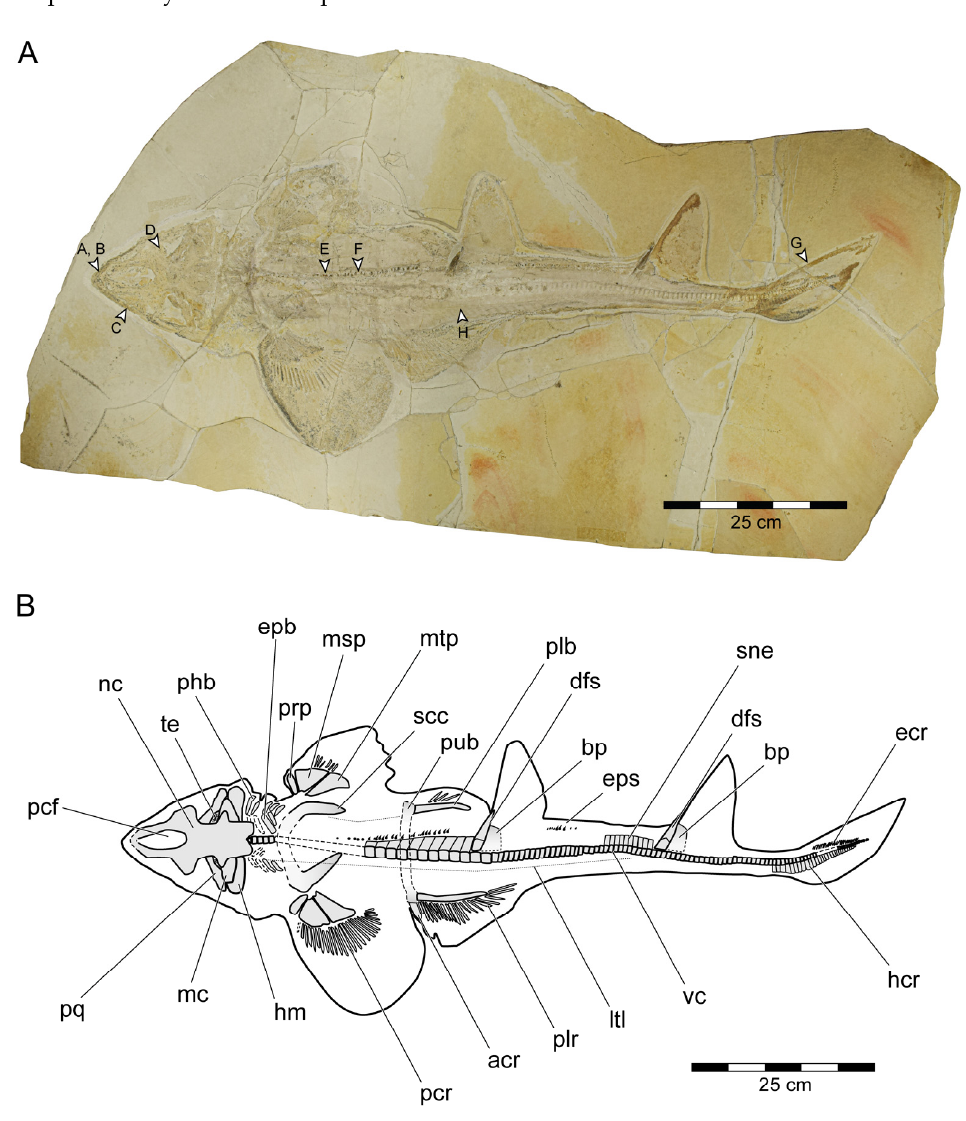
Figure 3. Protospinax annectans Woodward, 1918, PBP-SOL-8007, from the lower Tithonian of the Solnhofen Archipelago, Bavaria, Germany. ( A ) Slab containing the specimen. Arrowheads indicate the position of the dermal scales illustrated in Figure 8; ( B ) interpretative line drawing. Abbreviations : acr , anterior compound radial; bp , basal plate; dfs , dorsal fin spine; ecr , epichordal radials; epb , epibranchial; eps , enlarged placoid scales; hcr , hypochordal radials; hm , hyomandibula; ltl , lateral line; mc , Meckel’s cartilage; msp , mesopterygium; mt, metapterygium; nc , neurocranium; pcf , precerebral fossa; pcr , pectoral radial; phb , pharyngobranchial; plb , pelvic basipterygium; plr , pelvic radial; pq , palatoquadrate; prp , propterygium; pub , puboischiadic bar; scc , scapulocoracoid; sne , supraneuralia; te , teeth; vc , vertebral column.